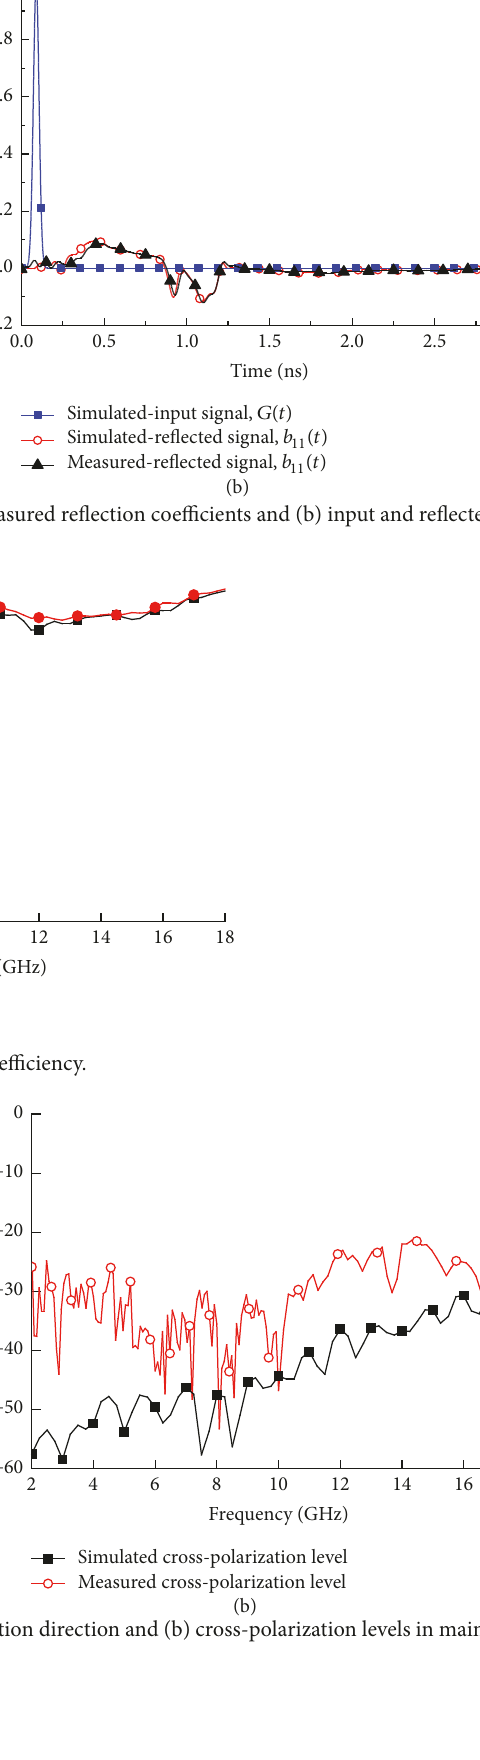
Figure 6: Gain and cross-polarization level. (a) Realized gain in main radiation direction and (b) cross-polarization levels in main radiation